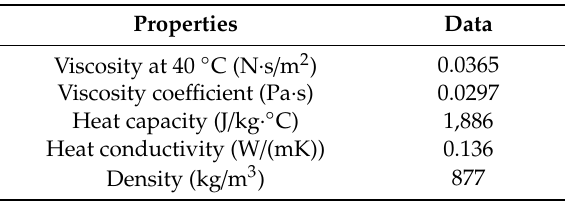
Table 2. Lubricant